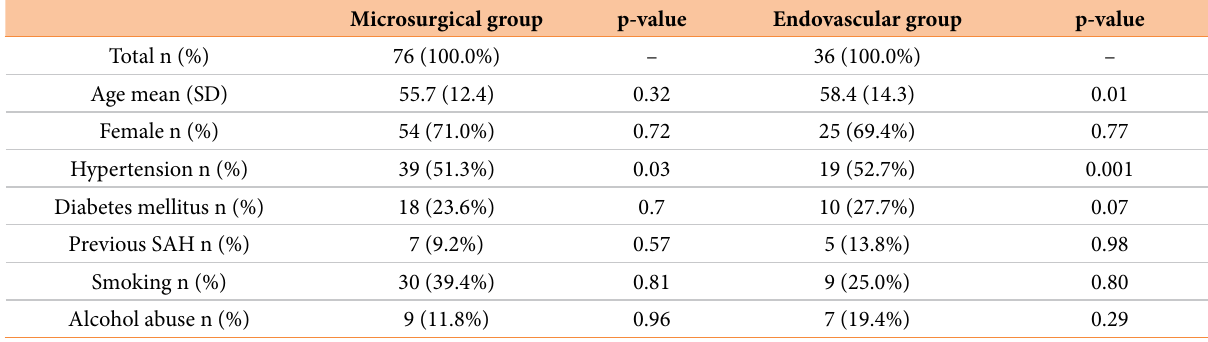
Table 1 - Demographic characteristics and its respective association with GOS score in follow-up.